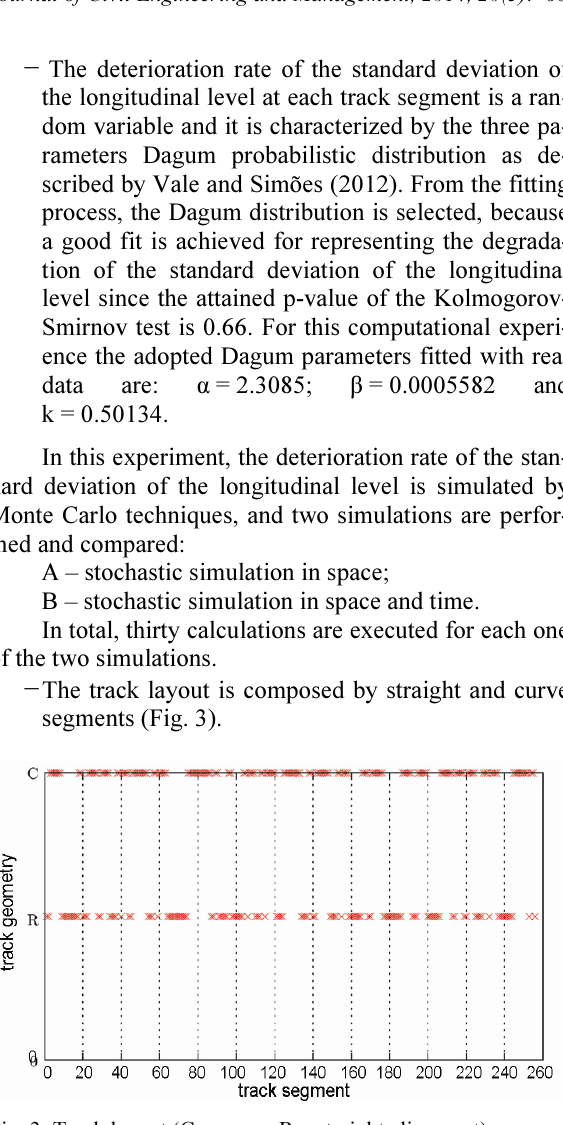
Fig. 3. Track layout (C – curve; R – straight alignment)